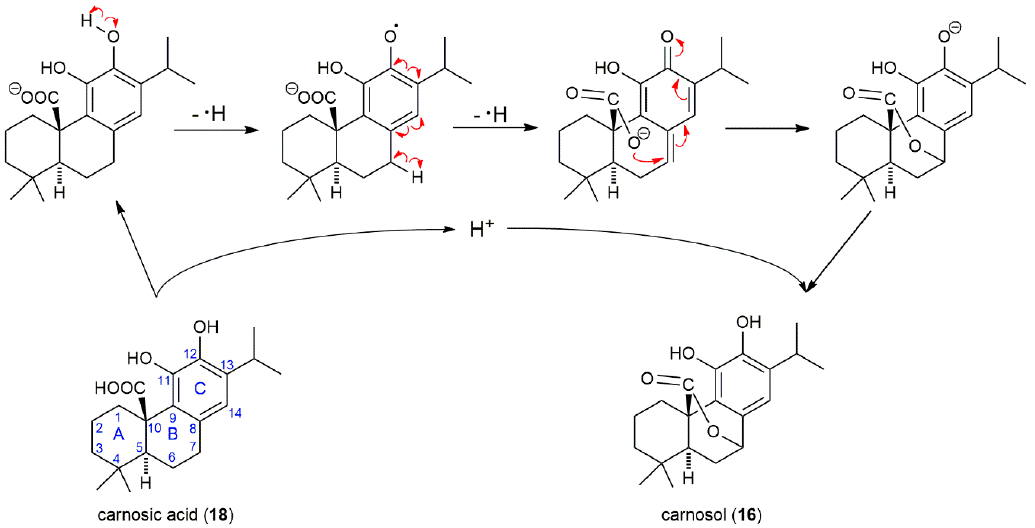
Figure 10. The suggested mechanism of CA oxidation to carnosol.